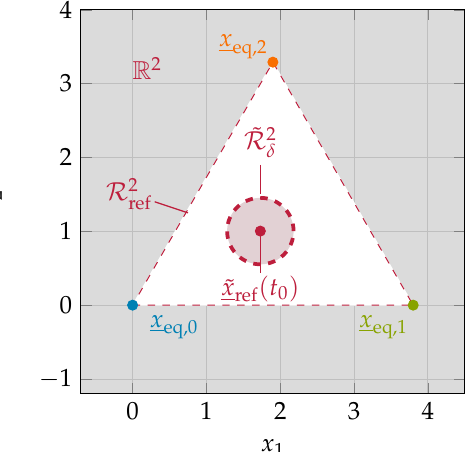
Figure 3. Shifted reference trajectory ˜ x ref ( t 0 ) subspaces R 2 x eq,1 , and x eq,2 with t 0 >